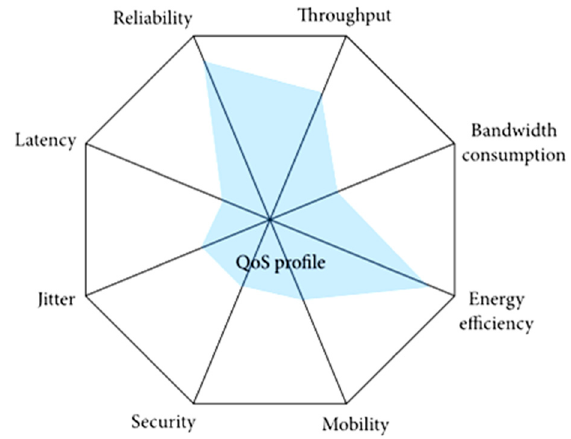
Figure 3. Quality of service (QoS) parameters in MANETs [139].